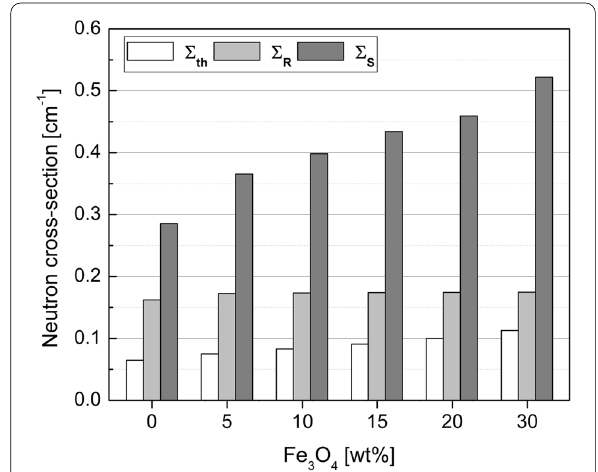
Fig. 8 Variations of A thermal neutron cross‑section and B fast neutron removal cross‑section with increasing Fe 3 O 4 nanoparticles